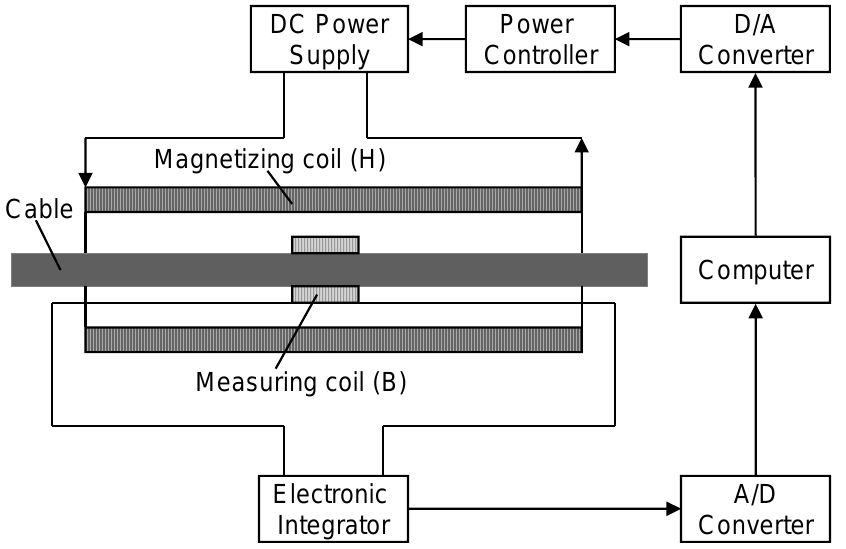
Figure 5. Schematic diagram of the experiment system for obtaining the magnetization curve of the